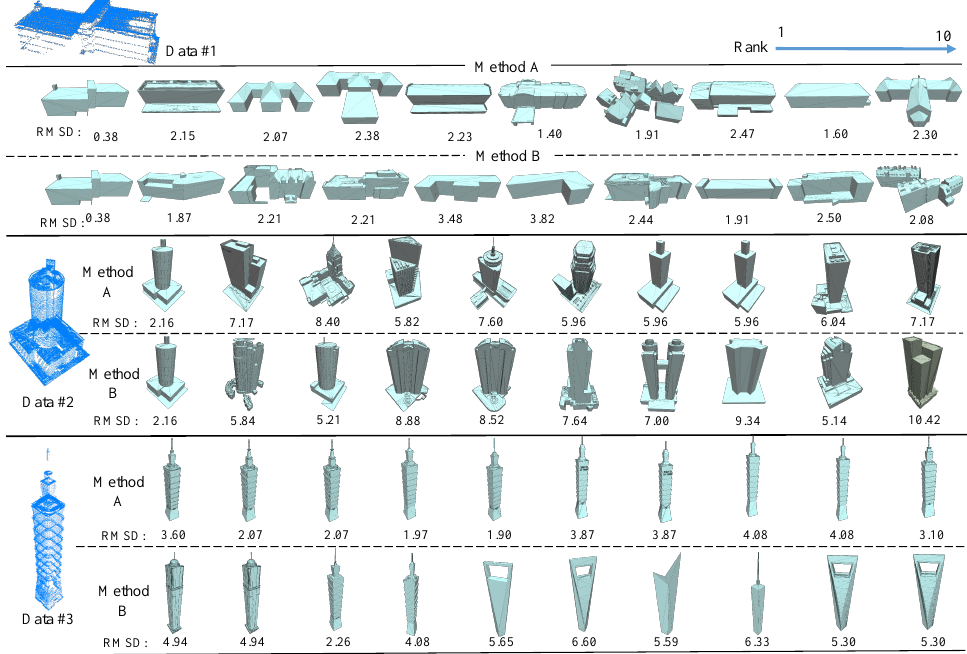
Figure 13. Comparisons among the retrieval results obtained by our method (Method A) and the related method [12] (Method